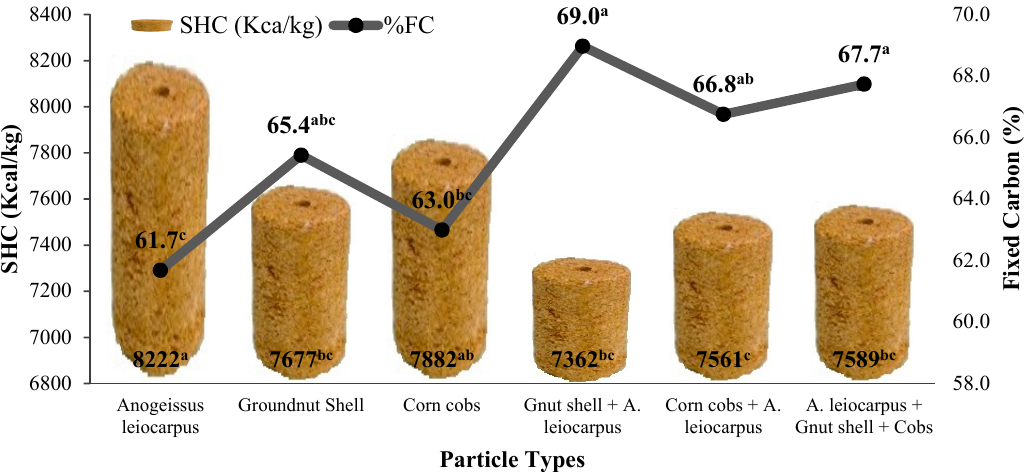
Figure 7. Effect of particle types on specific heat of combustion (SHC) and fixed carbon (% FC ) of the briquette. Means in the same bar having the same superscript are not significantly different ( p ≥ 0.05).